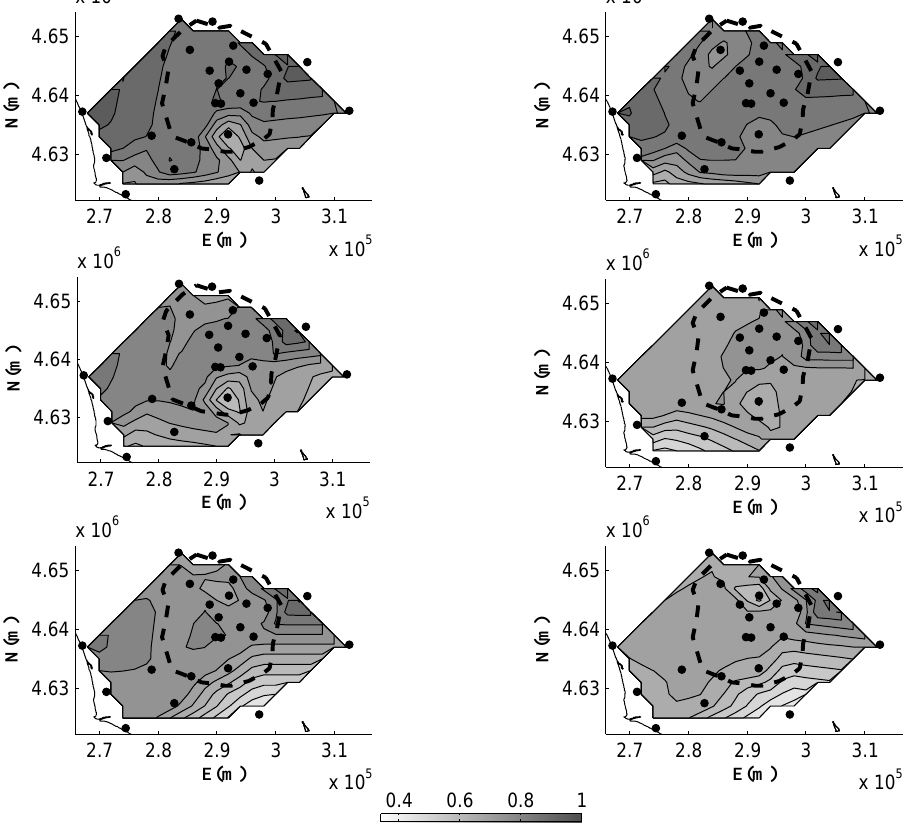
Fig. 6. Rome area isoinformation contours for sampling time intervals of d = 30min, 6 and 12h for summer (left) and winter (right) seasons. The colour bar varies from 0.34 to 1 and shows the value achieved by the nontransferred information index. The dashed line represents the Roman